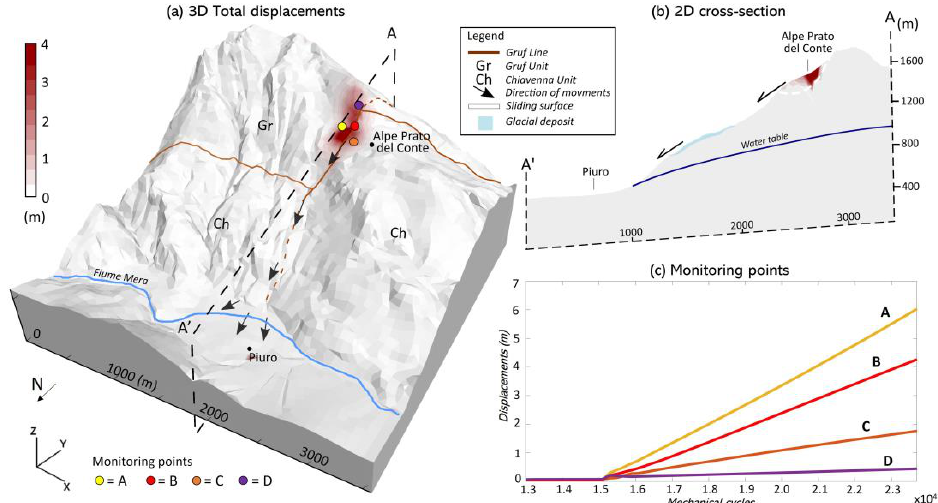
Figure 7. ( a ) 3D total displacements simulated at the end of the HM coupled analysis. ( b ) 2D total displacements along a N-S cross-section crossing the failure area. ( c ) Graph of measured displacements at monitoring points (Figure 6a) with mechanical cycles (defined as the number of timesteps performed).